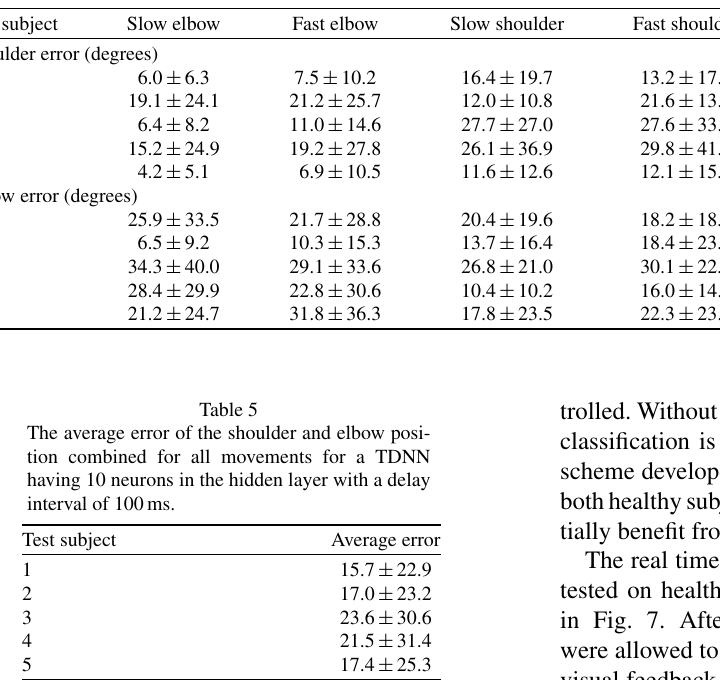
The error of shoulder and elbow position over each movement for each subject. Each TDNN had 10 neurons in the hidden layer with a delay